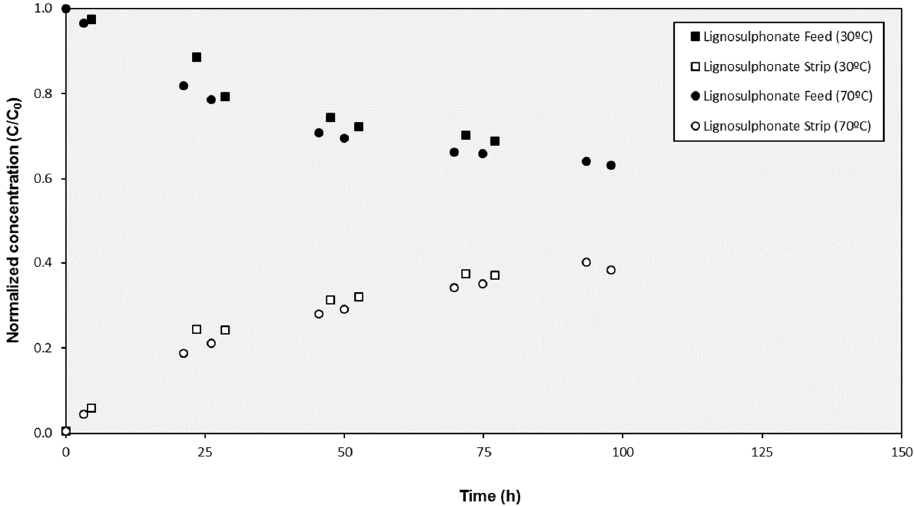
Figure 2. Evolution of the concentration of lignosulphonates in the cell compartments during tests with SILMs prepared at different temperatures.